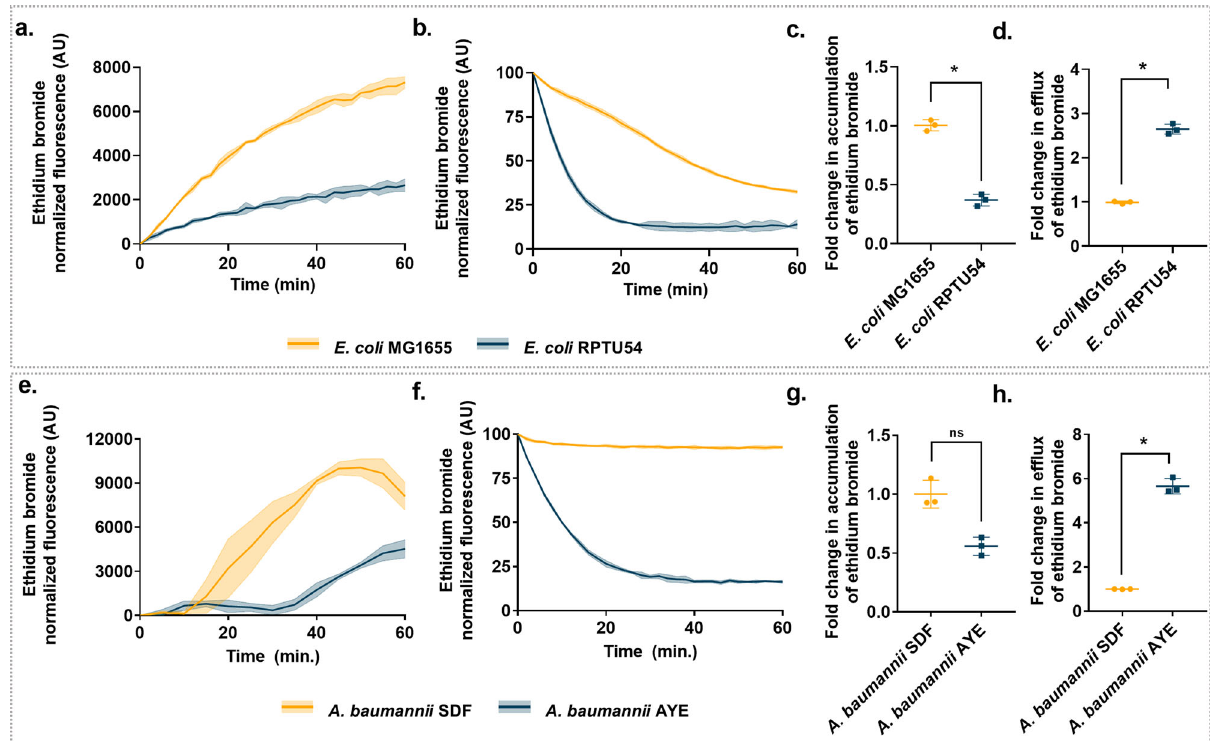
Fig. 6 Difference of accumulation and ef fl ux kinetics of ethidium bromide in quinolone-resistant vs. susceptible bacteria. a Accumulation kinetics, b ef fl ux kinetics, c fold change in accumulation, and d fold change in ef fl ux of ethidium bromide in E. coli MG1655 and E. coli RPTU54. e Accumulation kinetics, f ef fl ux kinetics, g fold change in accumulation, and h fold change in ef fl ux of ethidium bromide in A. baumannii SDF and A. baumannii AYE. Fold change was calculated from fl uorescence reading obtained at the end of 1 h. Solid lines represent mean and shaded regions represents error bars (SD). * denotes a signi fi cant difference of p < 0.05, ns denotes not signi fi cant; Wilcoxon matched-pairs signed-rank test. Data represents mean and SD from three independent experiments.